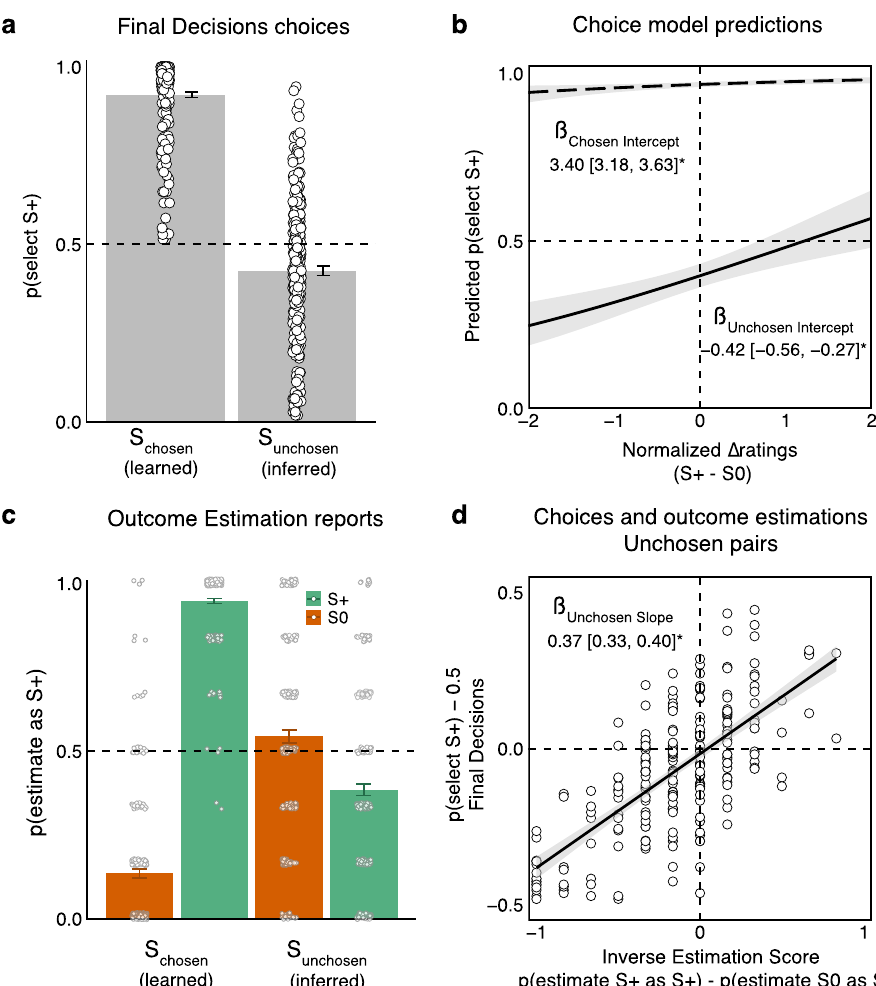
Fig. 2 The inferred value of unchosen options is inversely related to the learned value of chosen options (Experiment 1, n = 235). a When faced with a choice between two previously chosen stimuli, for which value was explicitly shown [S chosen (learned)], participants tended to select the rewarded option (S chosen + ), suggesting they successfully learned their values, while for pairs of previously unchosen options, which were never directly associated with any reward [S unchosen (inferred)], participants tended to select the option previously associated with an unrewarded item (S unchosen 0), demonstrating an inverse decision bias. b This inverse decision bias was observed even when controlling for initial subjective valuations of the choice options, in a Bayesian logistic regression predicting the probability to choose a rewarded item as a function of pair type and the difference in liking ratings. After rearranging the model coef fi cients, we can derive separate intercept terms for chosen and unchosen pairs. The intercept coef fi cient denotes the tendency to choose a rewarded item when there is no difference in liking ratings between the two choice options. For chosen pairs, the intercept is reliably positive, whereas for unchosen pairs it is reliably negative. c The inverse inference of value extends beyond the decision phase to explicit estimation of value. When asked to estimate the auction outcomes of each painting, participants correctly remembered the outcomes of the chosen paintings, yet showed the opposite pattern for the unchosen ones. d The tendency to select unchosen items previously paired with unrewarded items (S unchosen 0 over S unchosen + ) in the Final Decisions phase was correlated with an inverse estimation of value, i.e., the tendency to estimate S unchosen 0 as rewarded and S unchosen + as unrewarded in the Outcome Estimation phase. This relationship was assessed in a Bayesian linear regression predicting the mean probability to select rewarded items as a function of inverse estimation of value for chosen and unchosen pairs separately. In panels ( a ) and ( c ), error bars denote the standard error of the mean and points denote trial-averaged data of individual participants. In panels ( b ) and ( d ), the beta coef fi cients and model fi ts denote median and 95% highest density interval of the posterior distribution. In panel ( c ), green bars depict rewarded stimuli (S + ) and orange bars depict unrewarded stimuli (S0) (for unchosen stimuli, this is the outcome of their chosen counterpart). Source data are provided as a Source Data fi